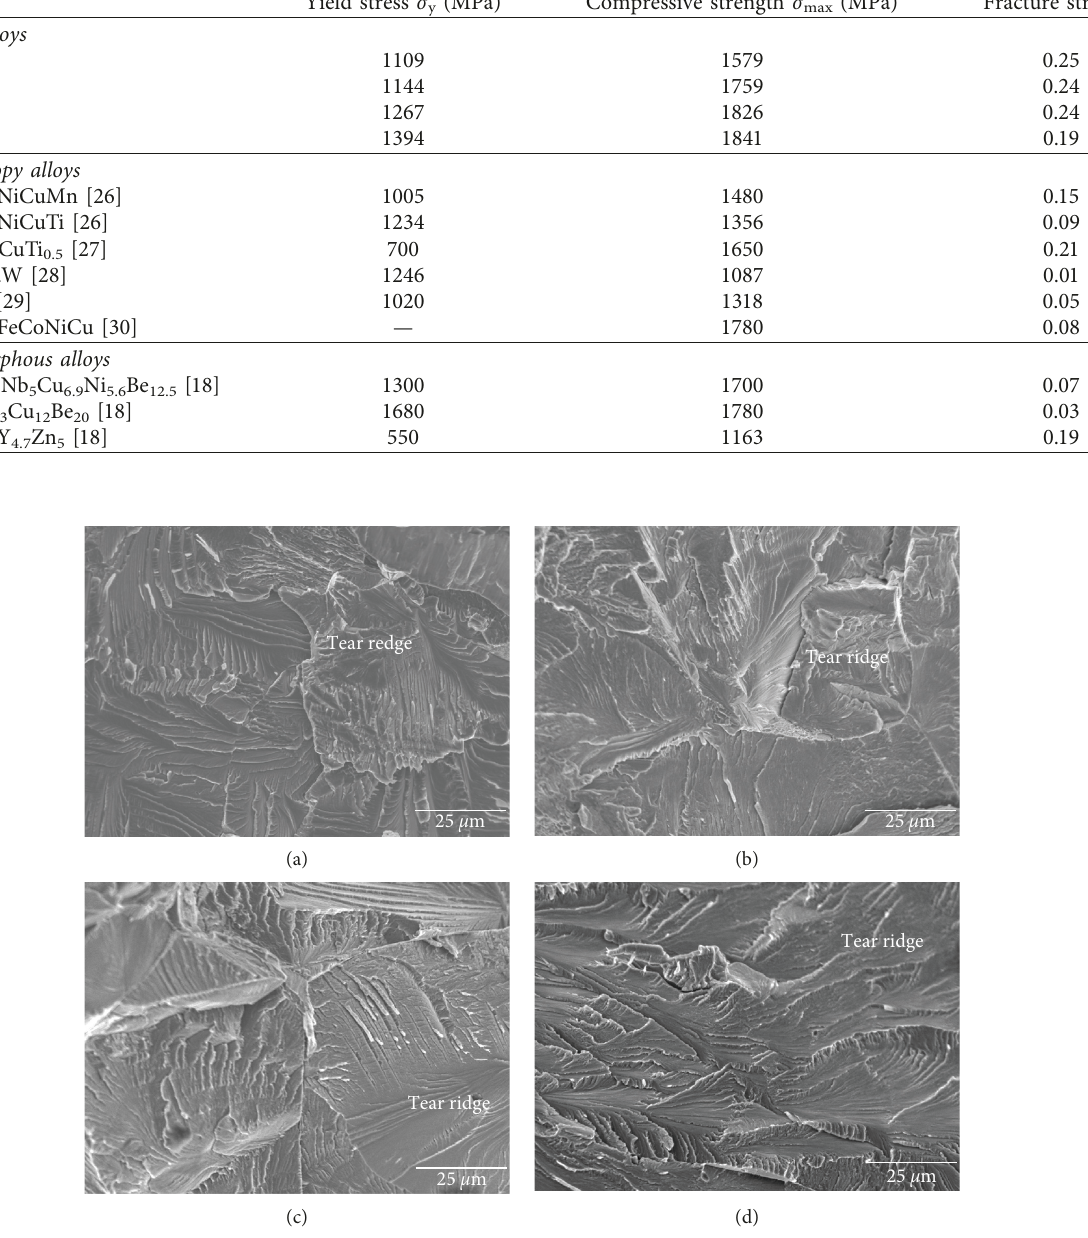
Figure 6: SEM images of the fracture surfaces after the compression of (a) Cr-0.3, (b) Cr-0.5, (c) Cr-0.7, and (d) Cr-1.0